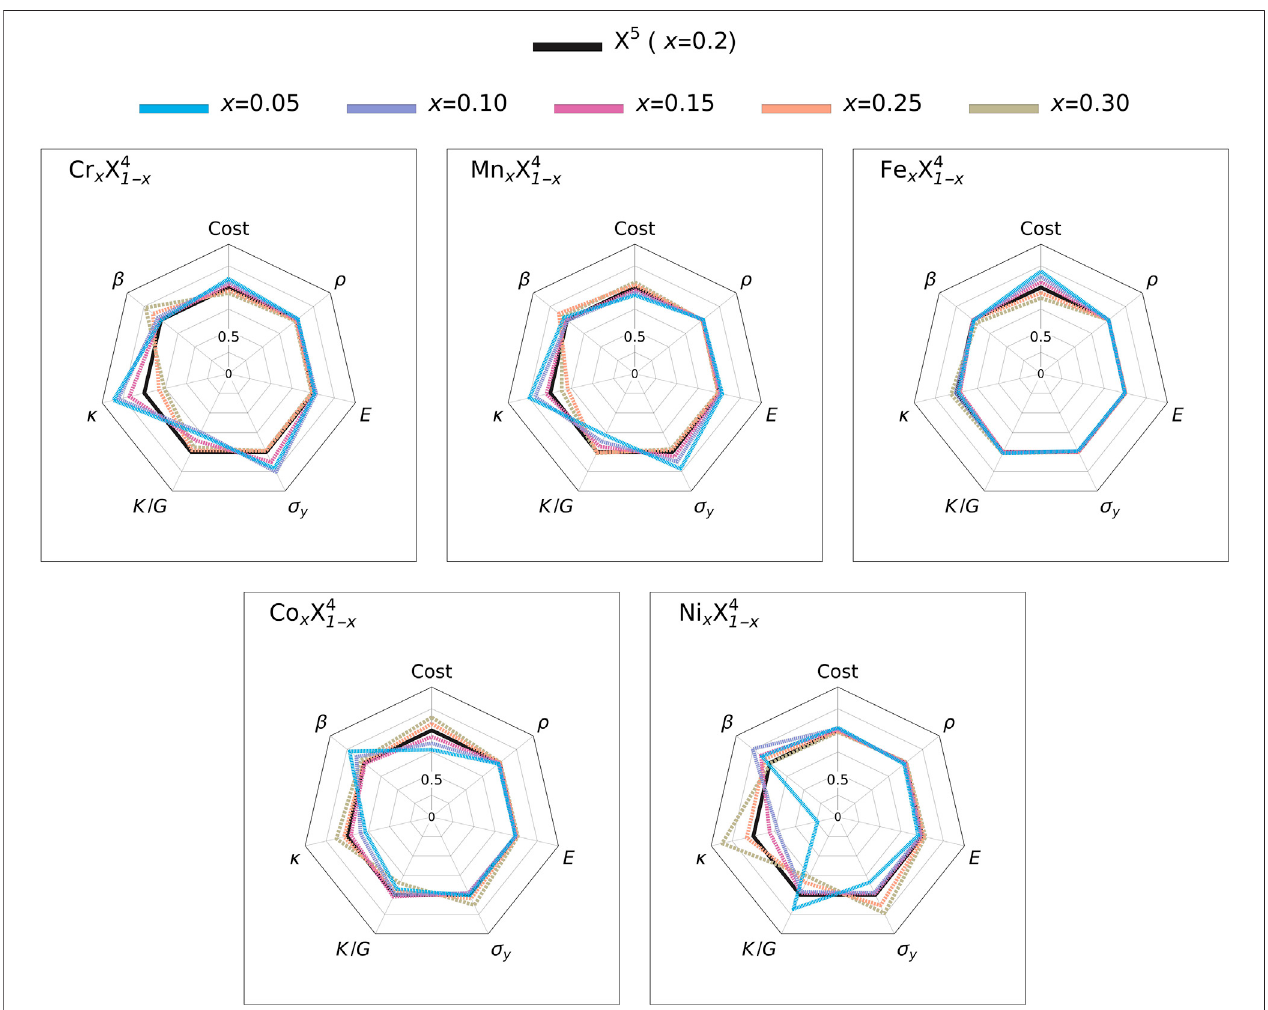
FIGURE 4 | Composition dependence of material properties of non-equimolar fi ve-principal-elements high-entropy alloys, shown by their ratio to those of CrMnFeCoNi (X 5 ), at T (cid:1) 1000 K.